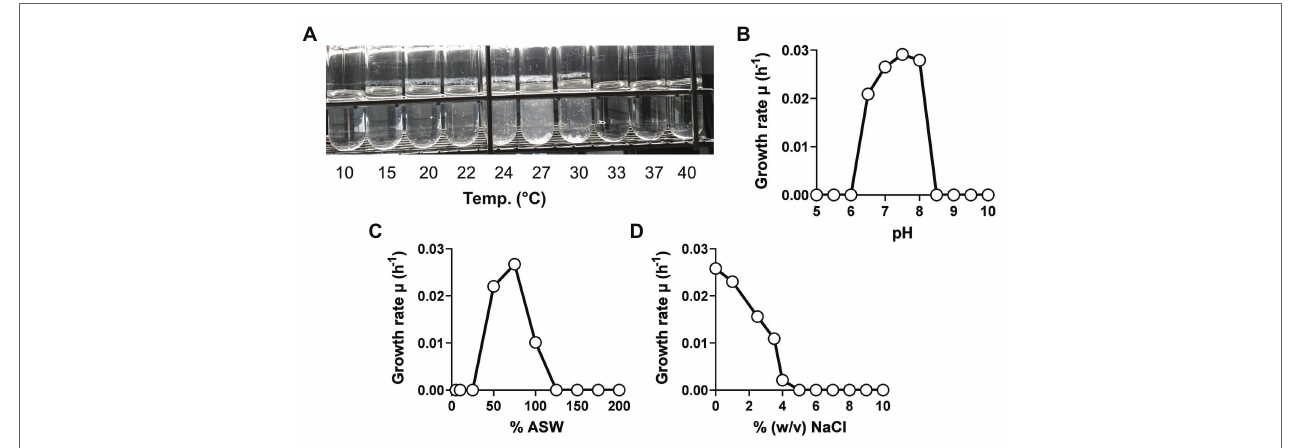
FIGURE 5 | Physiological characterization of strain KS4 T . Growth of strain KS4 T under different cultivation conditions was tested. Temperature (A) , pH (B) , artificial seawater (C) , and NaCl concentration (D) ranges enabling growth were analyzed by cultivation of the strain in M1H NAG ASW medium in biological triplicates. Due to the aggregation of cells at temperatures above and below the temperature optimum, no growth rates could be calculated for this experiment. The temperature optimum was determined by visual inspection of the cultivation tubes.